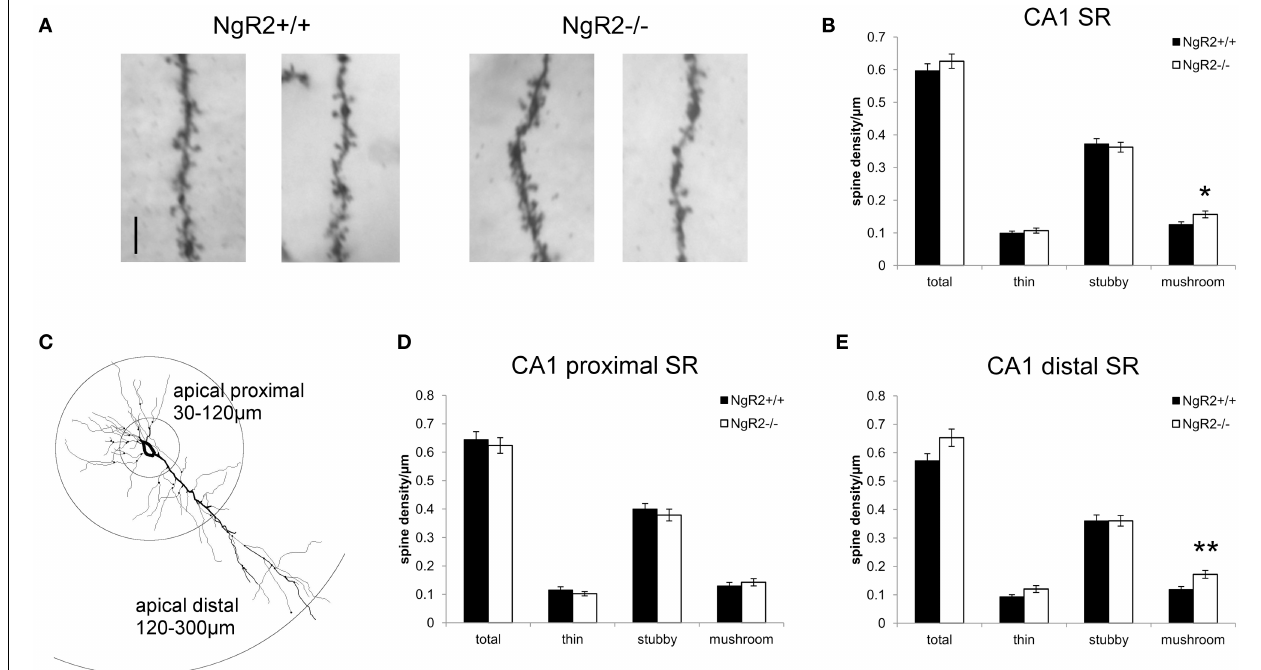
(3D tracing flattened to 2D), with definition of apical proximal and apical dendritic segments used to divide CA1 stratum radiatum (SR) for spine analysis in (D,E) . (D) Quantification of spine densities in apical proximal dendritic branches of CA1 SR. (E) Quantification of spine densities in apical distal dendritic branches of CA1 SR. A significant increase in mushroom spines was seen in NgR2 − / − compared to NgR2 + / + . n = 7 mice, ∗ p < 0 . 05, ∗∗ p < 0 . 005. Scale bar: (A) 5 μ